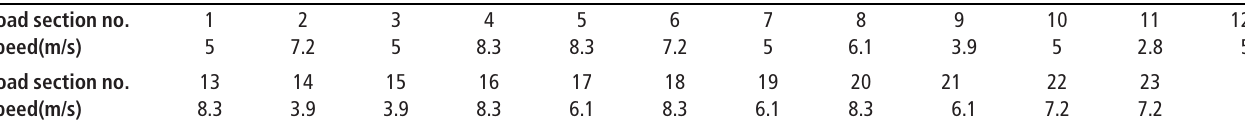
Table 6 Bus operating speeds on different road sections under plan II Road section no.